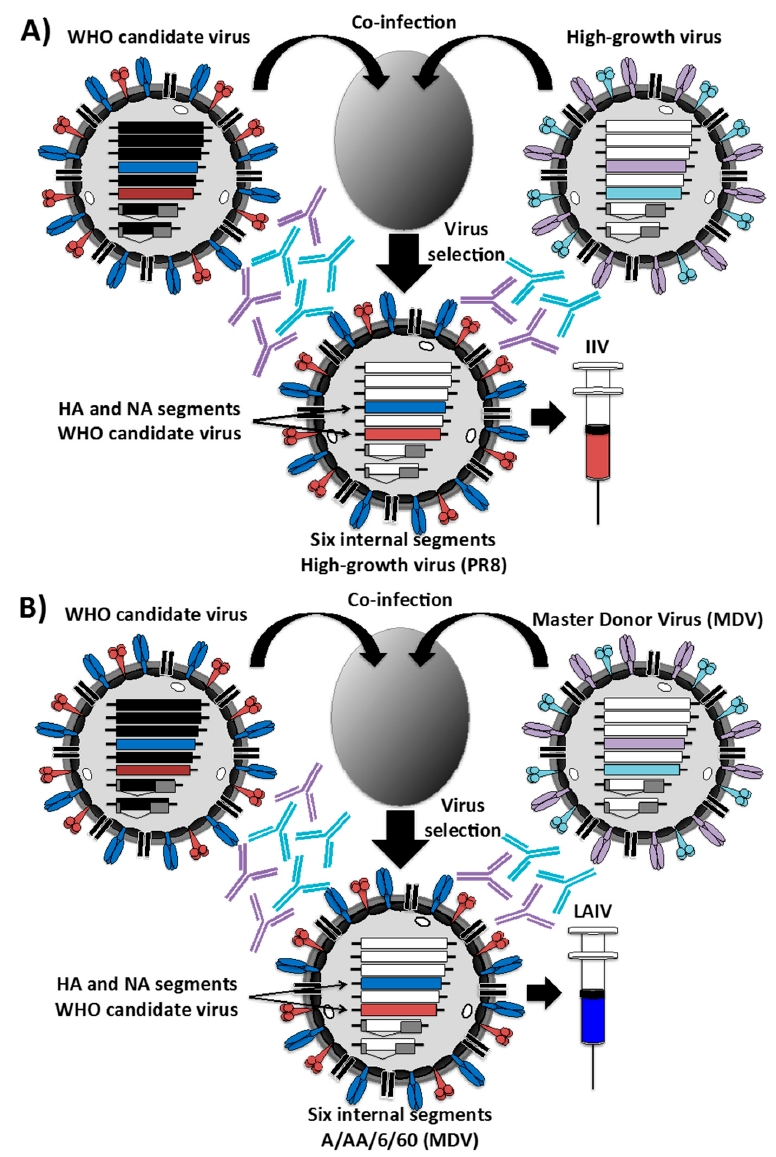
Figure 2. Schematic representation to produce inactivated ( A ) or live-attenuated ( B ) influenza vaccines by genetic reassortment in embryonated eggs: The traditional method for generating reassortant virus is based on the coinfection of two influenza viruses in eggs. Both the WHO candidate virus and the high-growth virus for influenza inactivated vaccine (IIV) ( A ) or the master donor virus (MDV) for live-attenuated influenza vaccine (LAIV) ( B ) are inoculated in eggs followed by the selection of appropriate seed viruses by amplification in the presence of antibodies against the HA and NA of the high-growth virus ( A ) or the MDV ( B ). The resulting viruses containing the HA and NA segments from the WHO-recommended strain and the six internal vRNAs of the high-growth virus ( A ) or the MDV ( B ) are used for vaccine production. PR8, Puerto Rico/8. LAIV have been available in the U.S. since 2003 and are administrated intranasally. The advantages of a live virus vaccine, as compared to the inactivated virus vaccine, is that it is applied to the nasal mucosa where the vaccine can induce local immunity (including NAbs), generate a cell- mediated immune response and provide a cross-reactive and longer lasting immune response [106].